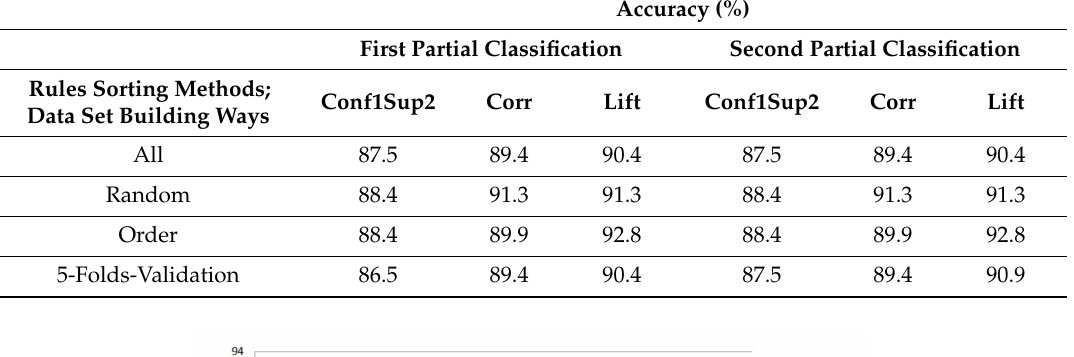
Table 1. Partial classification results of the proposed method.